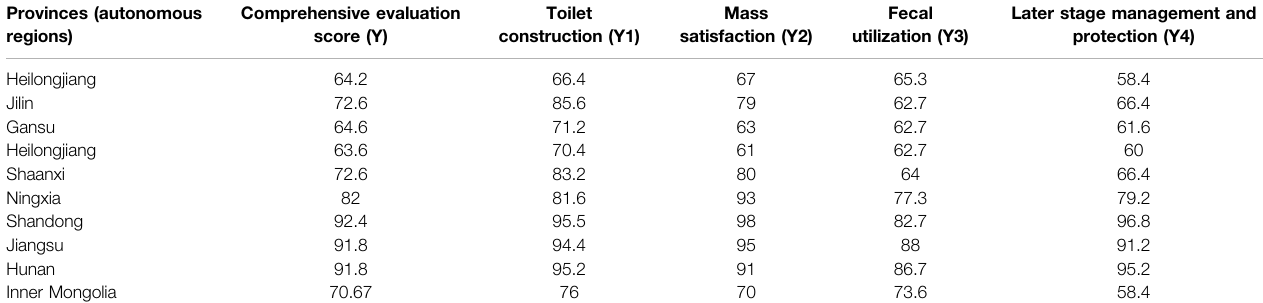
TABLE 4 | Comprehensive score and second-level index score of changing rural toilets into toilets in 10 provinces (autonomous regions). Provinces (autonomous regions)